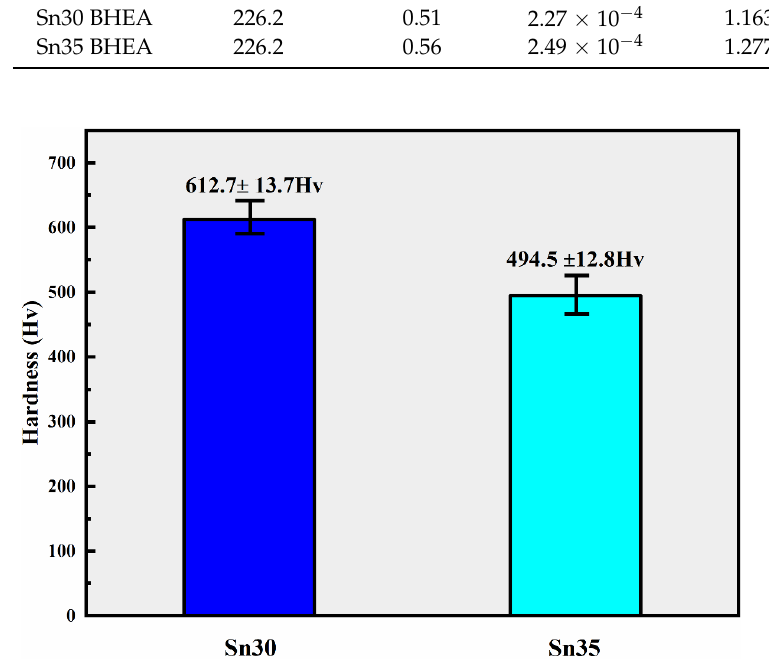
Figure 7. Hardness of the worn surface for the Sn30 BHEA and Sn35 BHEA. Table 3. Wear properties of Sn30 BHEA and Sn35 BHEA at room temperature.